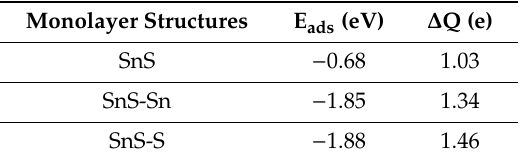
Table 3. Calculated adsorption parameters for NO 2 on various SnS monolayer